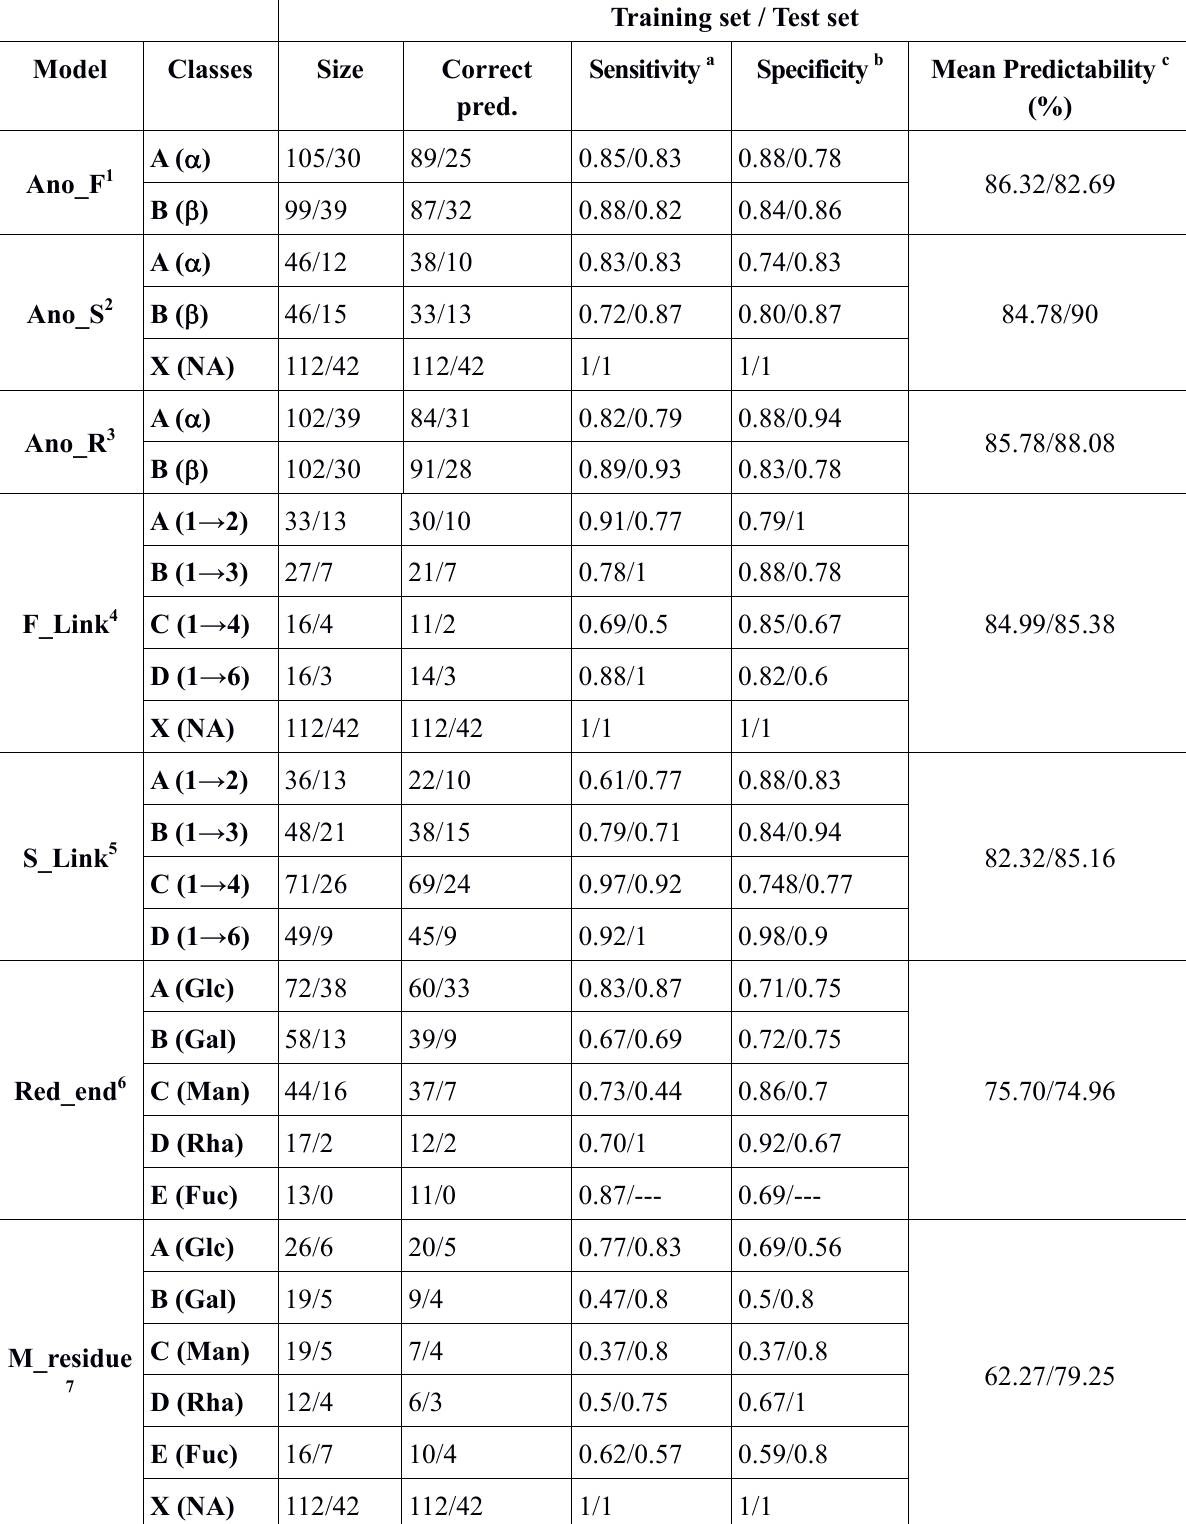
Table 3. RF predictions of the anomeric configurations, type of linkages, residues and chain type in 204 di- and trisaccharides for the training set and 69 for the test set using 1D 13 C-NMR